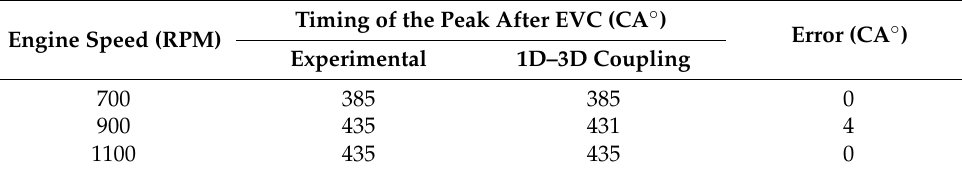
Table 5. Timing of the peak after EVC according to the engine speed.